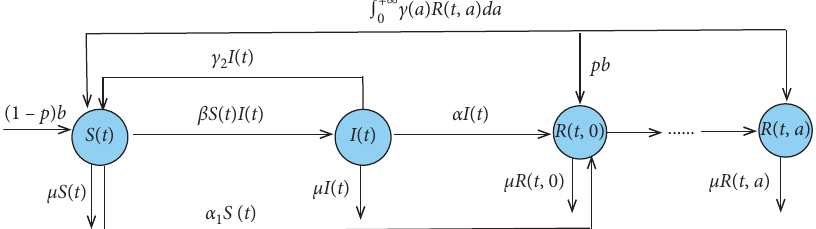
Figure 1: The flowchart of infection progression for the computer viruses based on the SIRS